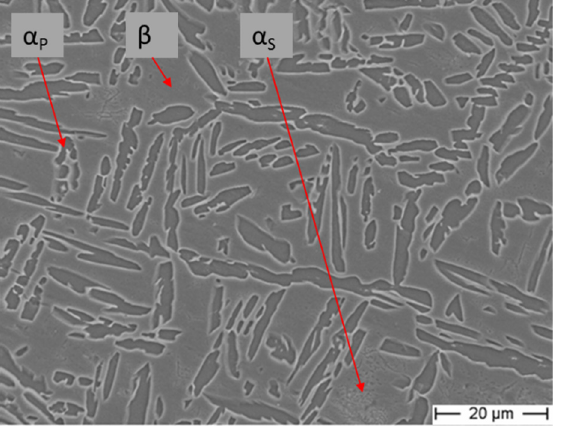
Figure 1. As-built microstructure of an EB-PBF Ti-5553 using E L = 600